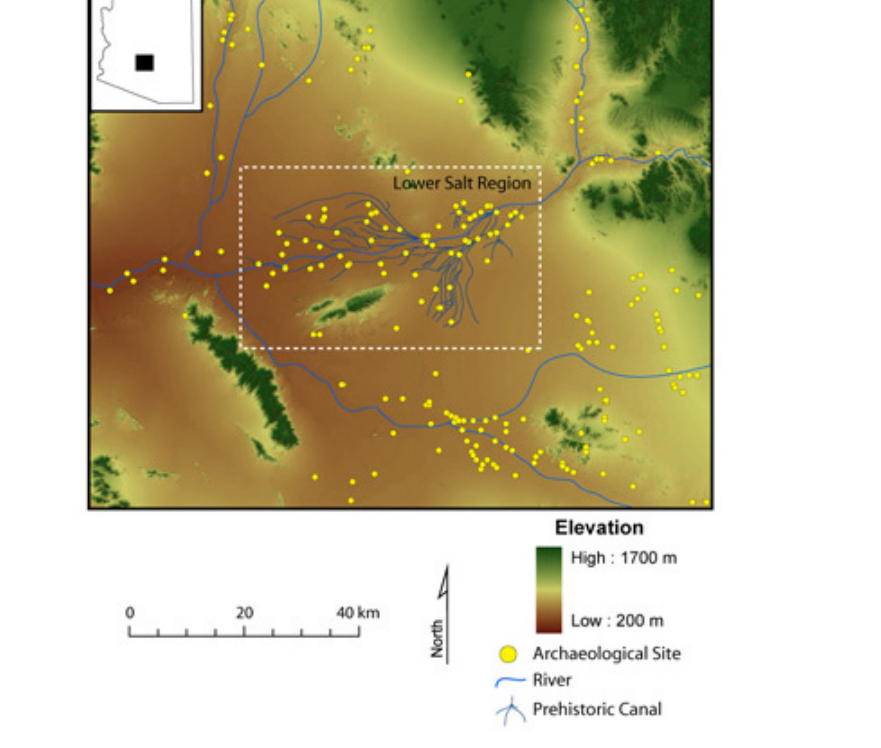
Fig. 13 . The Hohokam canal system in central Arizona was the largest prehistoric water control system in North